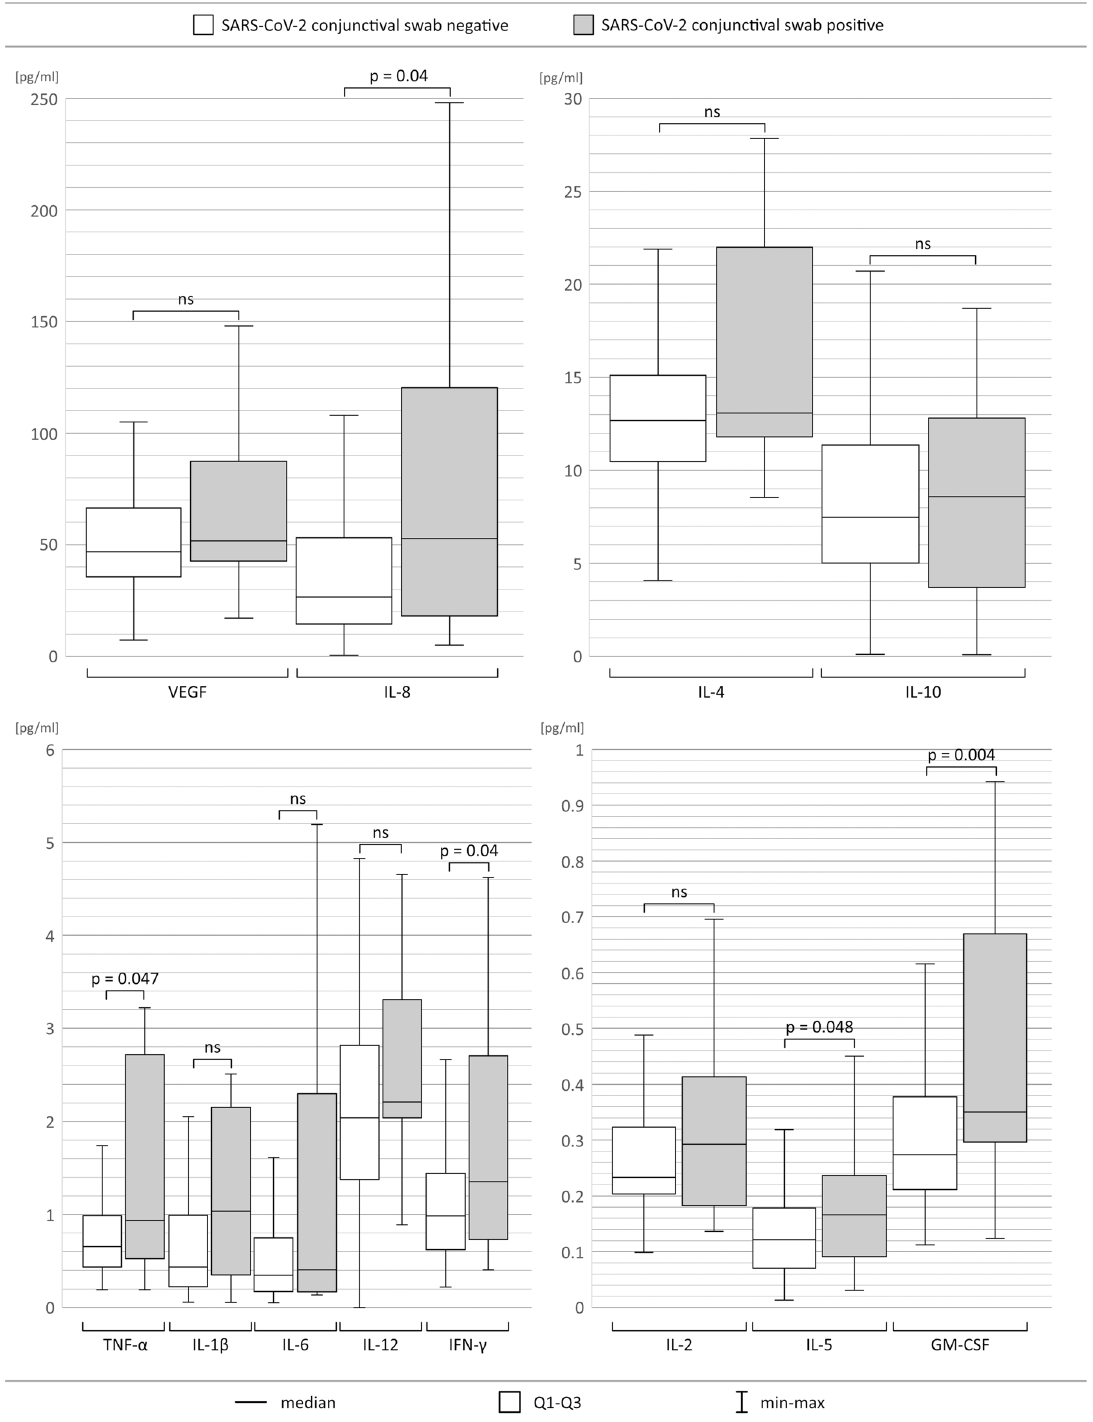
Figure 1. Boxplots showing tear film cytokine levels in patients with SARS-CoV-2-positive and SARS-CoV- 2-negative conjunctival swab results. Statistically significant p values are written above the boxplots. ns non